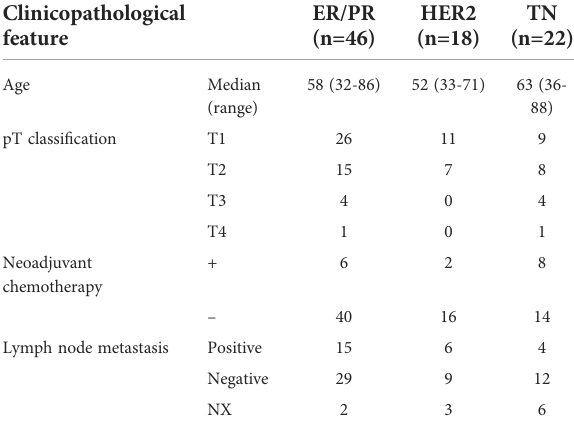
TABLE 1 Clinicopathological features of patients included in this study.